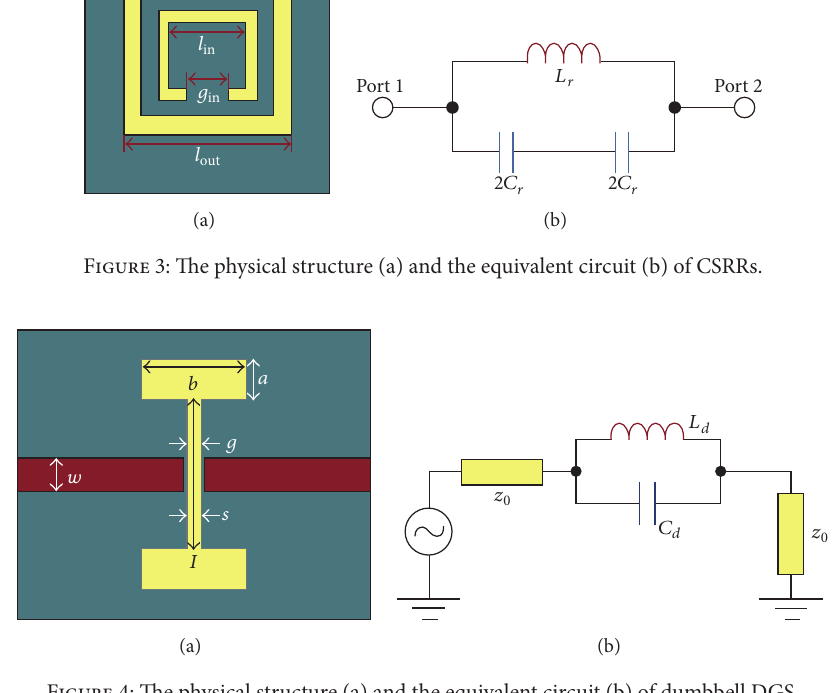
Figure 4: The physical structure (a) and the equivalent circuit (b) of dumbbell DGS.